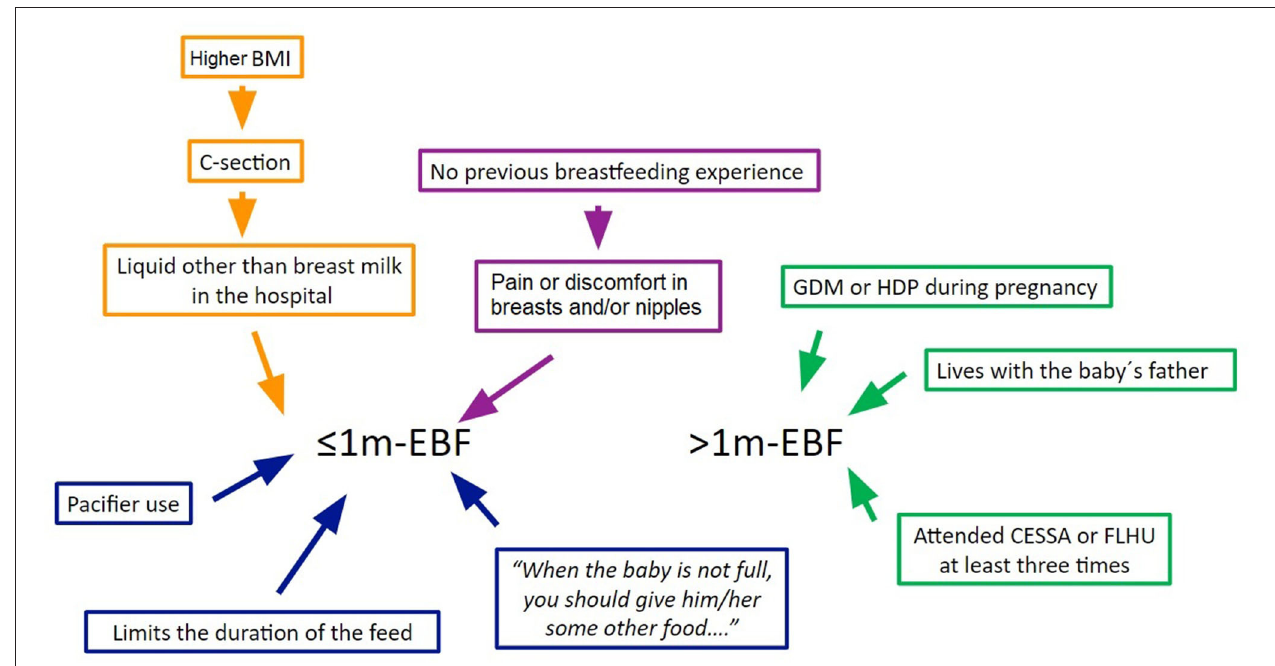
FIGURE 6 | Conceptual model of maternal / infant factors related to EBF. ≤ 1 m-EBF = up to 1 month exclusive breastfeeding; > 1 m-EBF = beyond 1 month exclusive breastfeeding; GDM, gestational diabetes mellitus; HDP, hypertensive disorder of